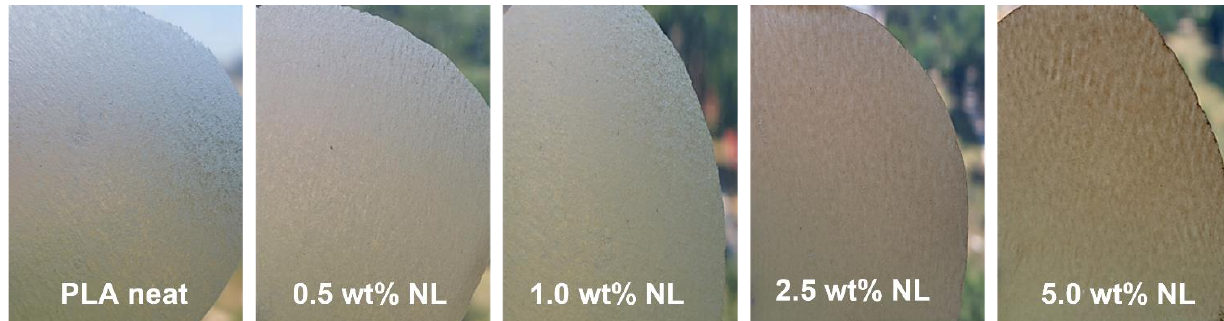
Figure 15. Optical properties of the neat PLA and PLA − Lignin ( left ) and PLA − Nanolignin ( right ) composites.